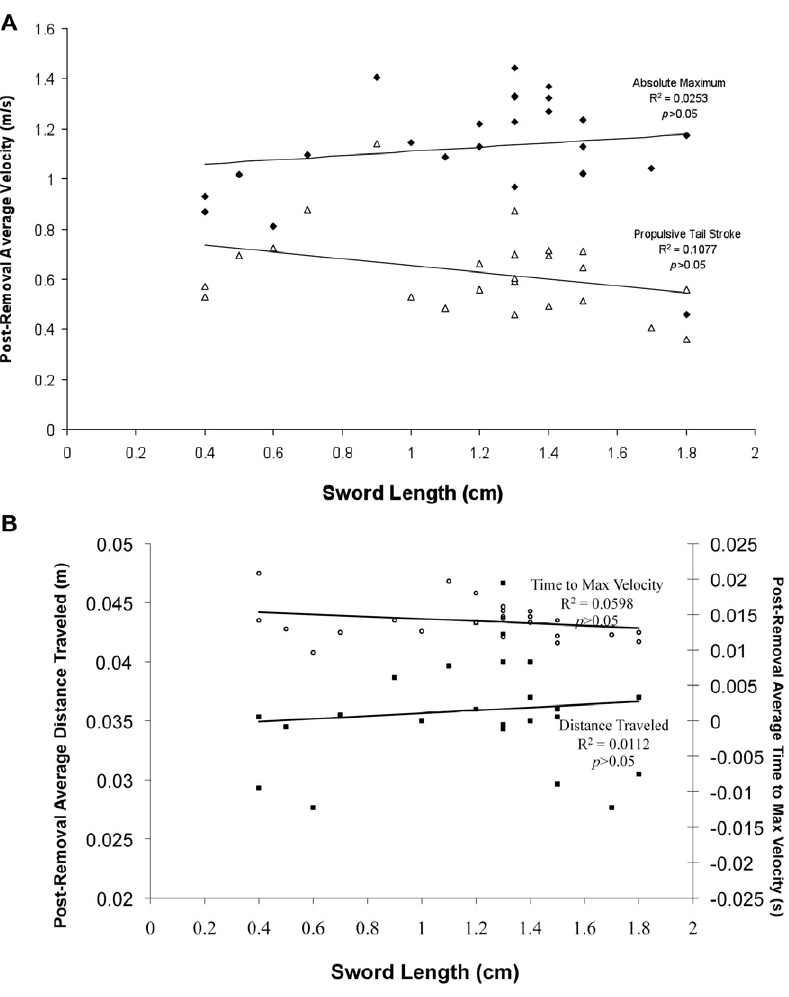
Figure 4. Males with long swords are not inherently better performers. As in Figure 2, four escape performance variables are shown for each individual against the length of its sword. However, here we compare the fish’s escape performance after its sword was removed to its original sword length. Panel A shows two post-removal measures of escape velocity—absolute maximum velocity (stage 1) and maximum velocity during the propulsive tail stroke (stage 2)—against the original length of the individual’s sword. Panel B shows two other post-removal measures of escape performance—total distance traveled and time taken to reach the maximum velocity—against the original length of the sword. Low R 2 values indicate that individuals with longer swords are not inherently better at performing escape response maneuvers than those with short swords.